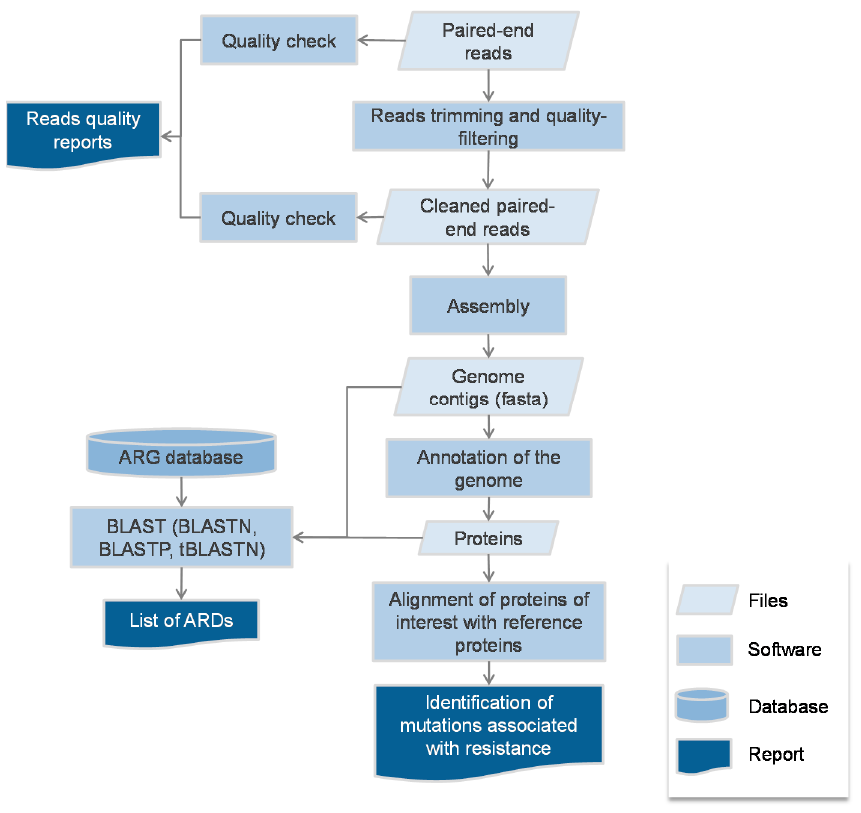
Figure 1. Typical bioinformatics flow-chart of the genotype-to-phenotype studies.